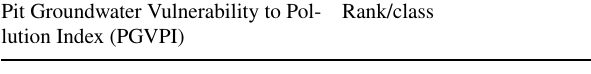
Table 2 Division into grades due to the value of the groundwater vul- nerability index in the area of direct contact of post-mining wastes with groundwater Pit Groundwater Vulnerability to Pol- lution Index (PGVPI)